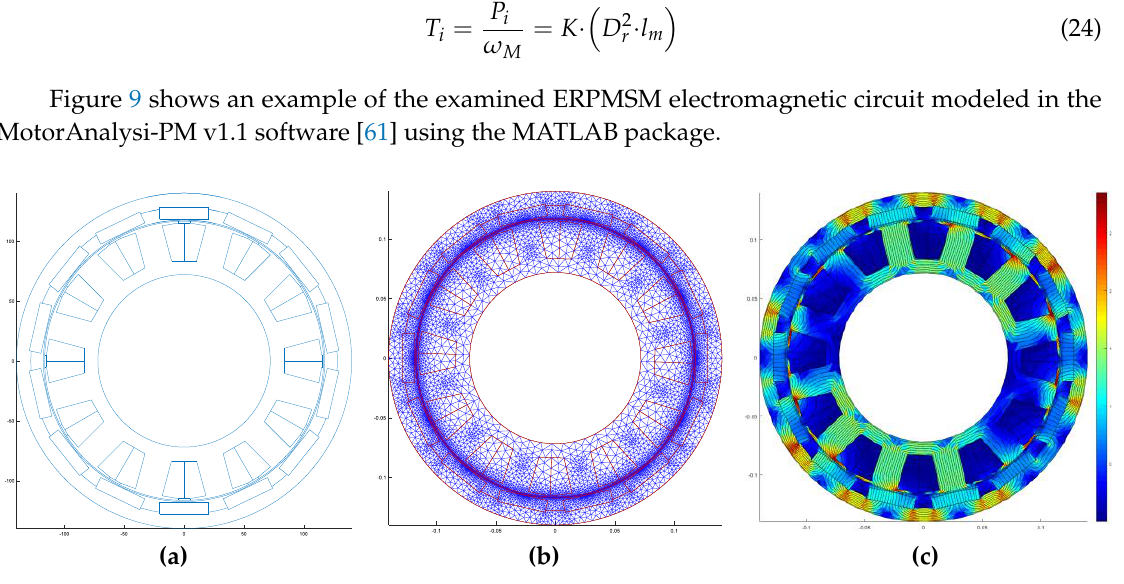
Table 1. The results of initial numerical calculations of the motor with concentrated coils wound with 16 turns of wire with a CSA of 13.4 [mm 2 ].